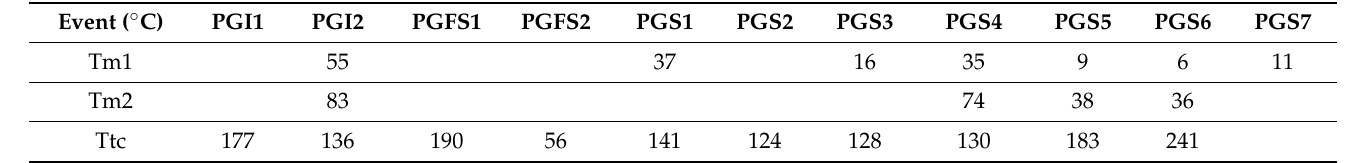
Table 2. DSC results of PGI1 and 2, PGFS1 and 2, and PGS1–7 .